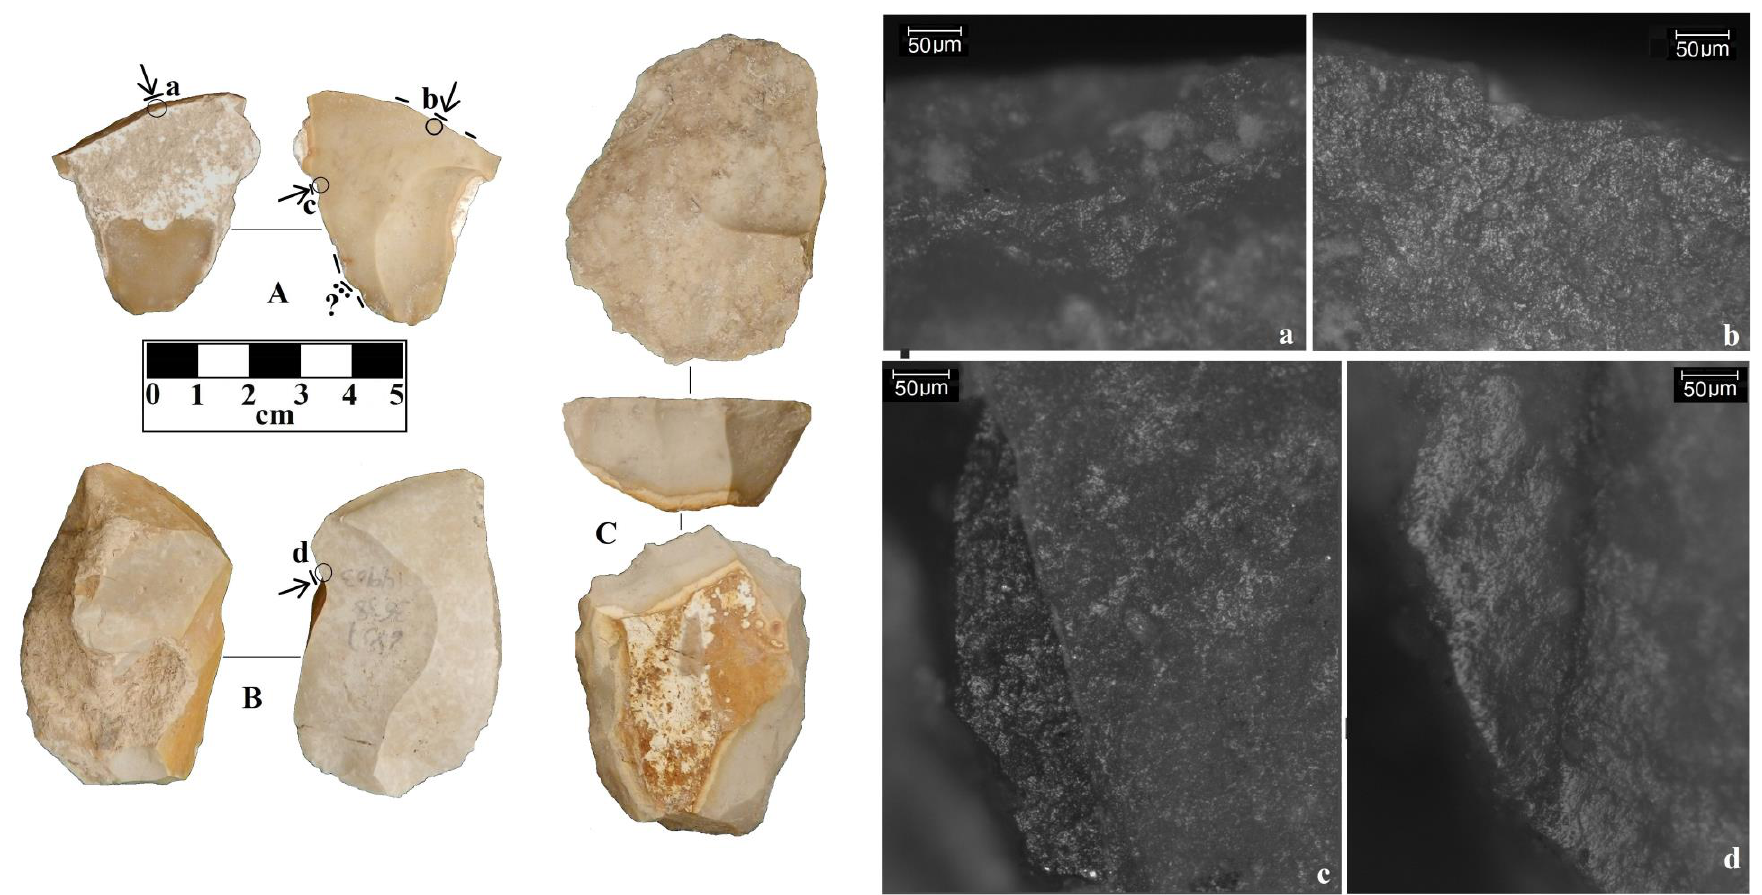
Figure 3. Dorsal (left or bottom), ventral (right or top), and lateral (middle) faces of cores-on-flakes (COFs) from Wadi Rabah layers at Ein-Zippori. White chalky cortex and caliche cover most of their dorsal faces. White lines show the extent of the usewear traces, arrows show orientation of the microwear polishes and striations, line with dots shows possible prehension traces. Circles show locations of photomicrographs a , b , c , and d . A : COF with lateral snap from Area B, Locus 3538, Bucket 14858, item#1. B : Lustrous COF from Area B, Locus 3538, Bucket 14903. C : COF from Area C, Locus 9025, Bucket 90157 with several flake removals around perimeter, but no visible use wear. a : Bright bone and rough hide or meat polish at medial distal edge (dorsal) of A . b : More extensive rough hide or meat polish on right distal edge (ventral) of A . c : Streaks of bright bone or stone traces and rough hide or meat polish in small notch on distal left lateral edge (ventral) of A . Possible prehension traces were noted on the proximal portion of same edge. d : Edge-rounding, striations, hide polish and stone-on-stone wear on distal left lateral edge (ventral) of B . photomicrographs are at 187.5x, scales are 50